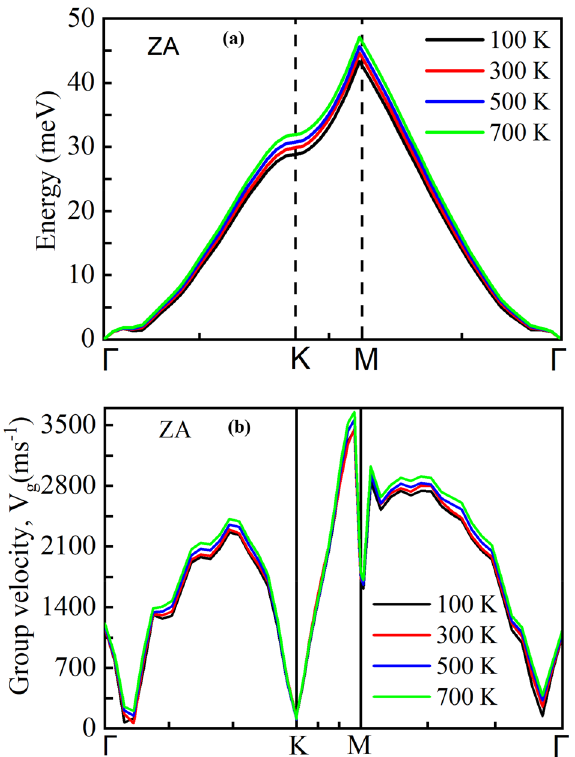
Figure 11. ( a ) Variation of the phonon-dispersion relation and ( b ) phonon group velocity of the ZA mode phonon at different